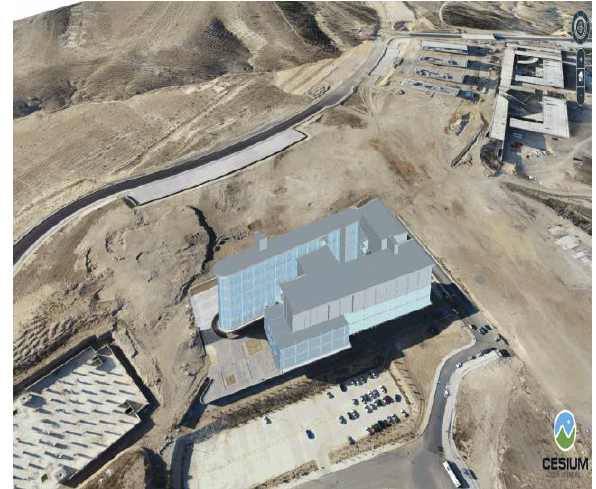
Figure 12. CAD to BIM in Cesium Ion.